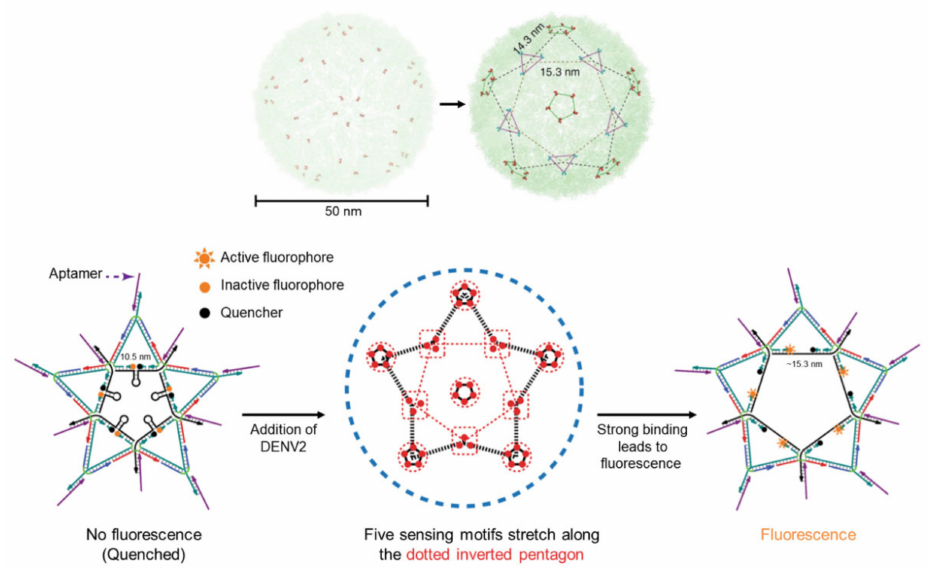
Figure 17. ( top ) A star motif found in spatial patterns of epitopes of the dengue virus (DENV). ( bottom ) Design strategy of a DENV-targeting sensor based on a star-shaped DNA nanoarchitecture. Reprinted by permission from Springer Nature Ltd.: Nat. Chem. 2020, 12, 26–35, doi:10.1038/s41557- 019-0369-8. Copyright (2020)